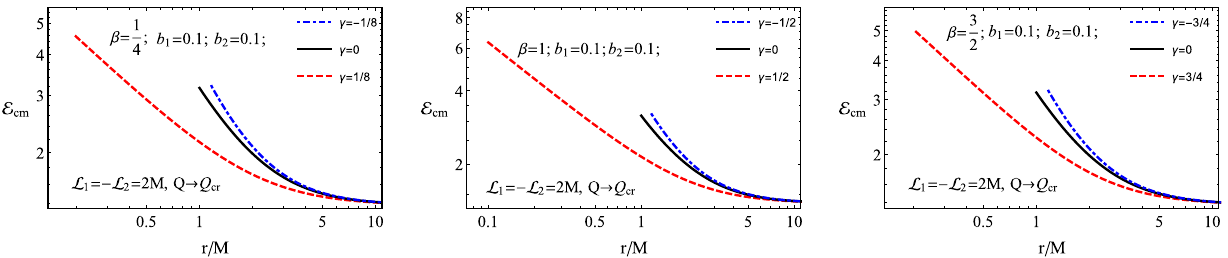
Fig. 14 Dependence of center of mass energy of two magnetized particles with respect to β for different values of the magnetic parameter b , at the corresponding values of γ and critical charge